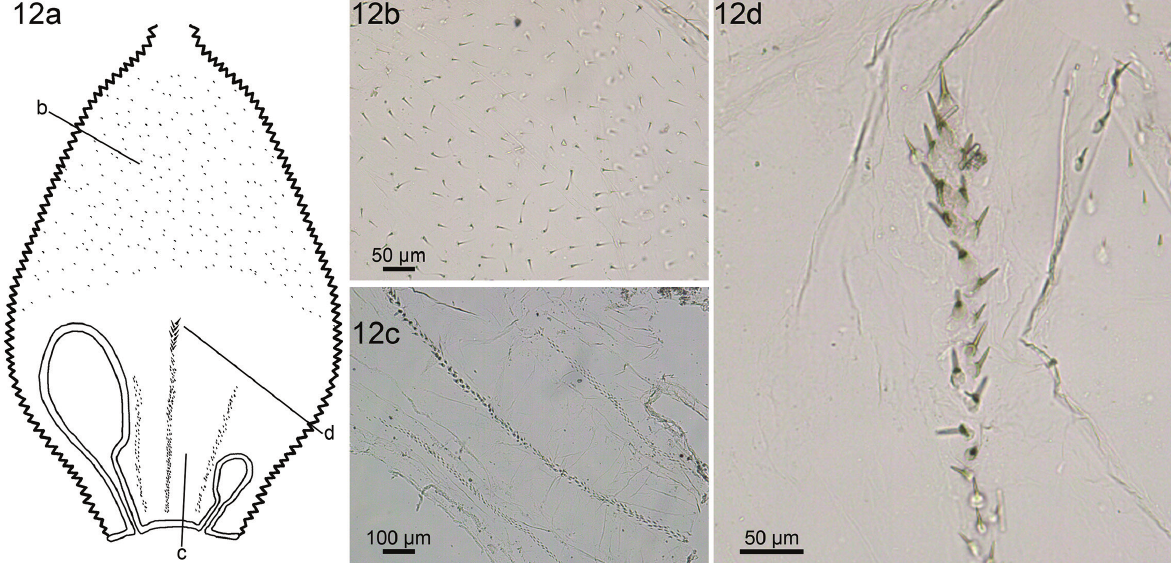
Figure 12. Labiotermes emersoni . (a) Schematic drawing of P1 showing arrangement of spines. (b–d) Photomicrographs: (b) Detail of spines in the distal region; (c) General view of the three branches of spines between the mesenteric tongues; (d) Detail of middle branch of